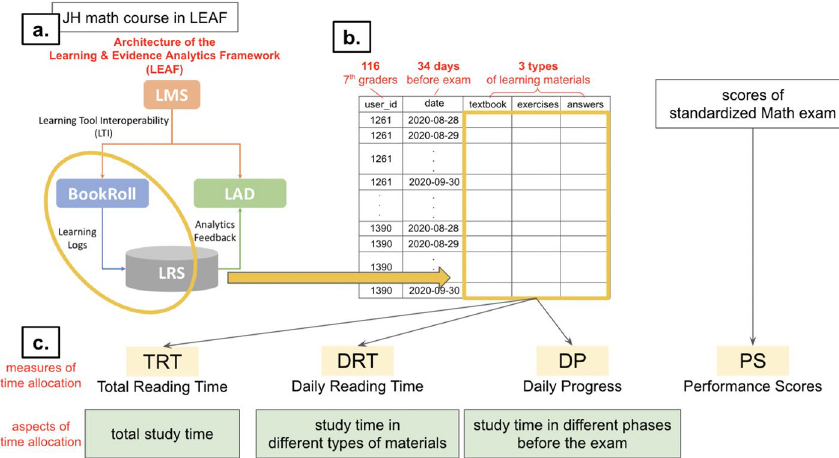
Fig. 3 Extracting learning data from architecture of the learning & evidence analytics framework